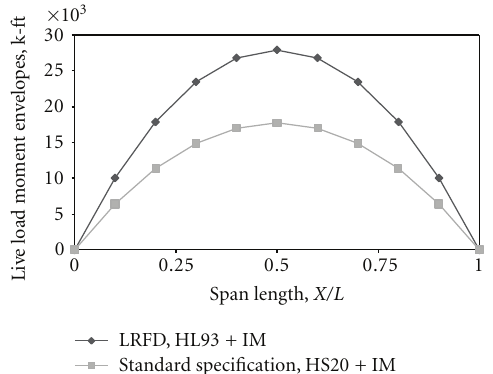
Figure 1: Comparison of moment envelopes due to only dis- tributed live load plus impact for 180 ft single-span box girder with eight webs spaced at 9ft.